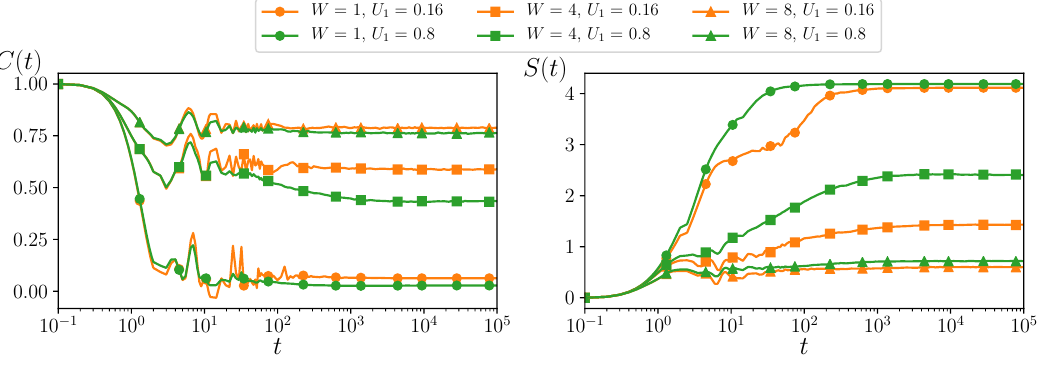
Figure 11: Time evolution of the density correlation function C ( t ) and of the entan- glement entropy S ( t ) for N = 7 spinless fermions on K = 14 sites for the extended Hubbard model with quasirandom disorder, Eq. (16), for U = 0 and the long-range = 0.16,0.8. The results are averaged over 1000 values of interactions strengths U 1 the phase φ in the interval [ 0,2 π ] , the initial state is a Fock state with random site occupation and N = 7.